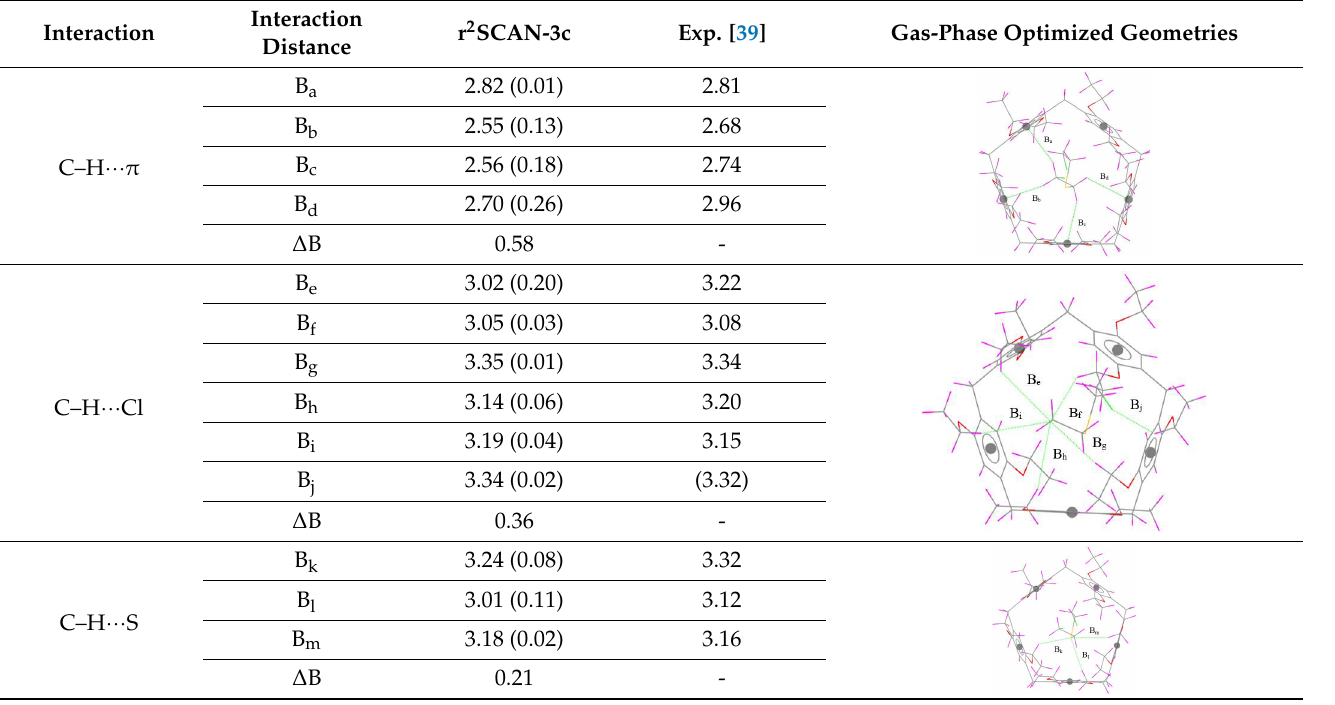
Table 1. Experimental and computed nearest intermolecular distances (Å) of SM@EtP[5] complex. (The values in brackets represent the difference between the computed and the experimental dis- tances). Interaction